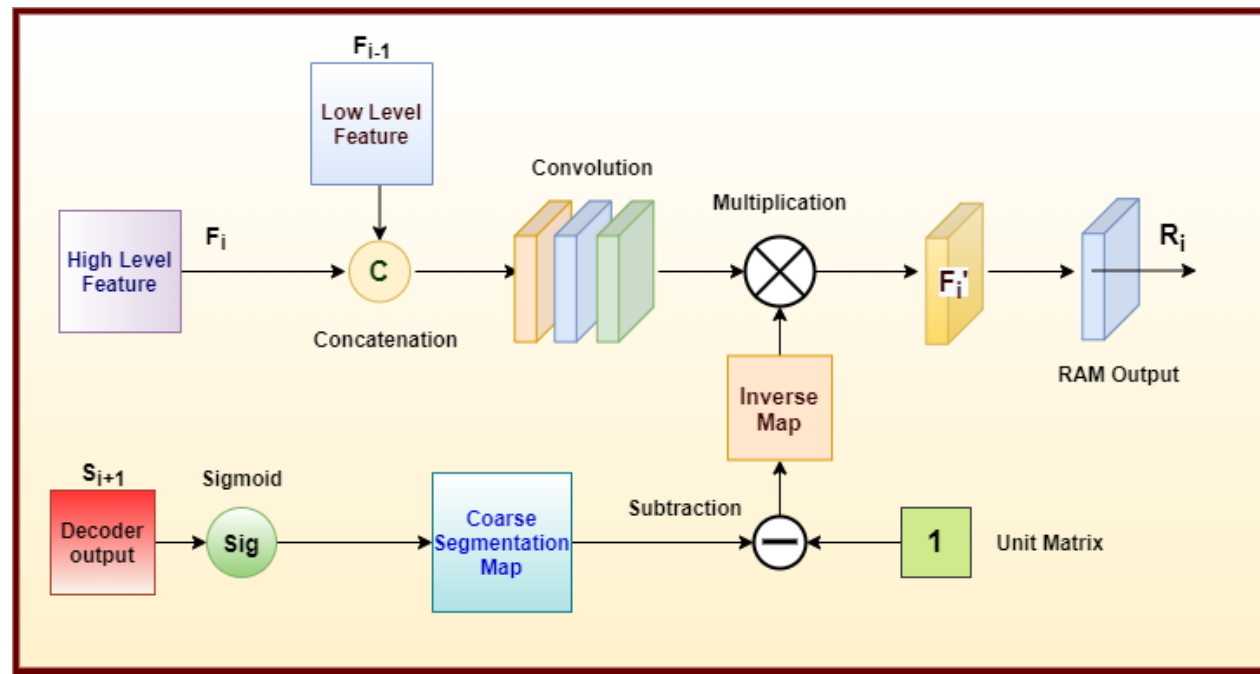
Figure 2. Workflow of the REM taking three inputs: (i) the intermediate enhanced map form the decoding layers of the REM S i + 1 , (ii) encoded feature map of the first convolution F i , and (iii) input feature map from the from skip connections F i − 1 . The feature maps, F i and F i − 1 from the skip connections of PM are concatenated together to undergo a series of convolutions. The output thus obtained is multiplied with the additive inverse of S i + 1 . The final reverse attention map R i is generated on balancing the number of channels by 1 × 1